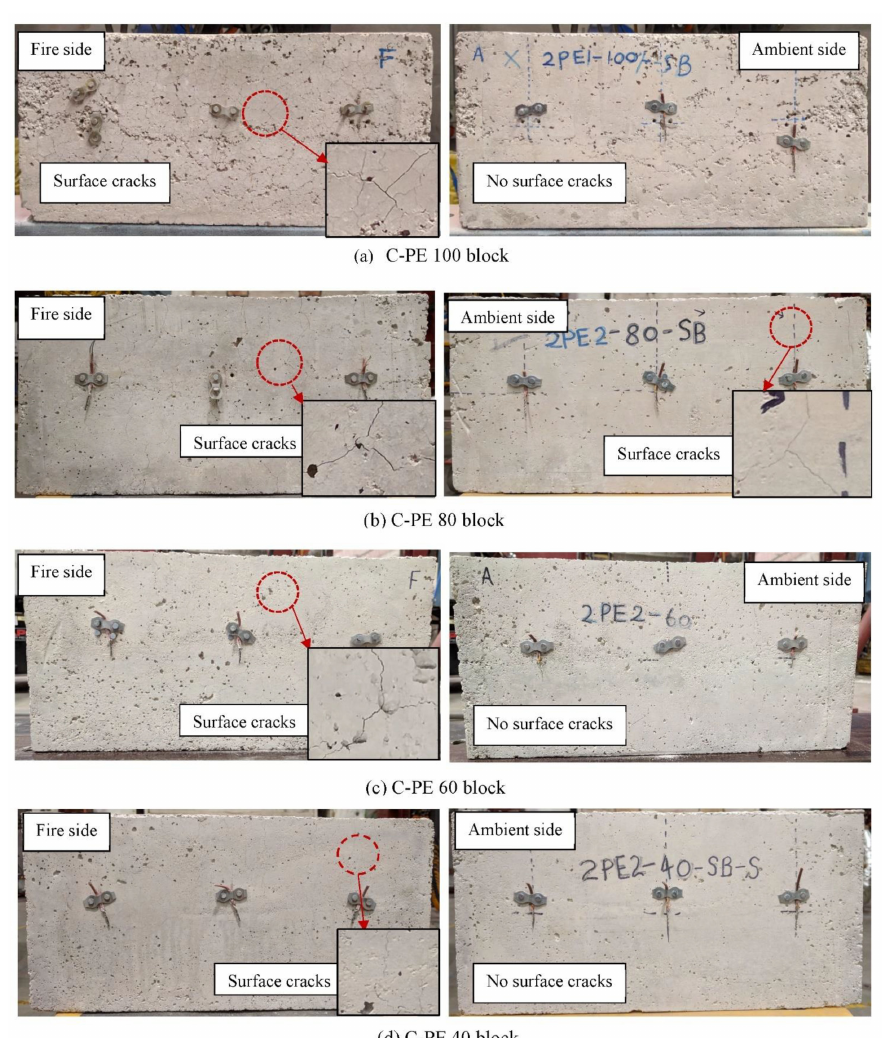
Figure 28. Fire-exposed and ambient side surfaces of C-PE blocks after the bushfire